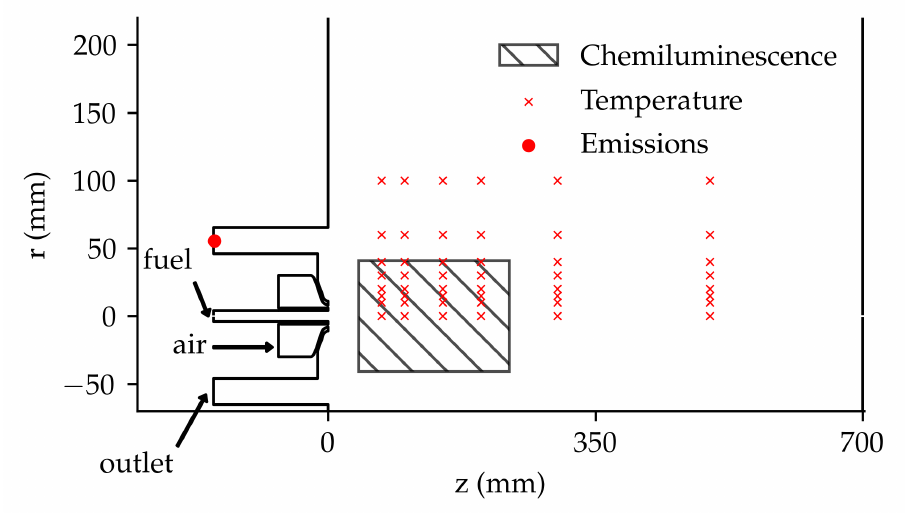
Figure 3. Position of the sensors relative to the outline of the ULB furnace. Operating Conditions